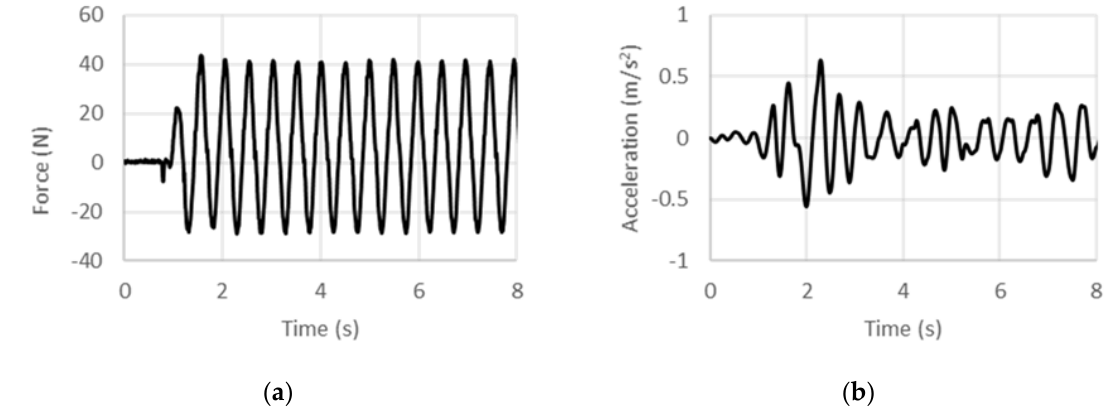
Figure 7. Experimental ( a ) force and ( b ) acceleration histories at 1 Hz under displacement control.